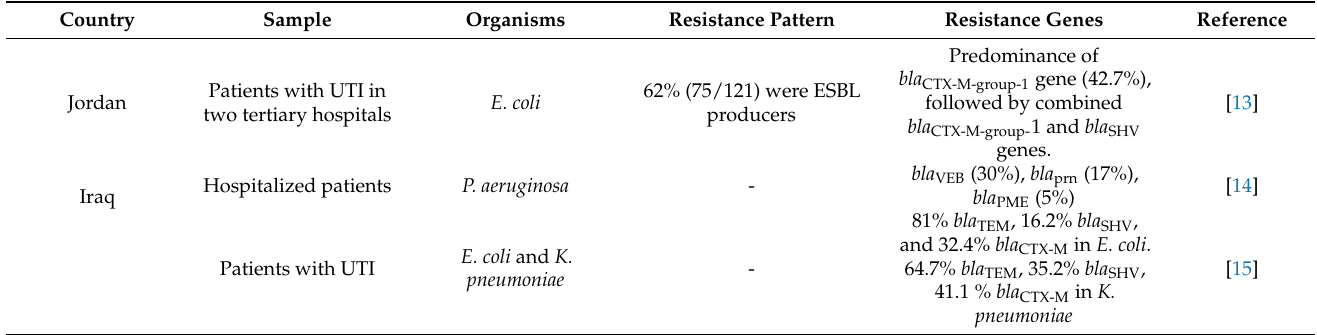
Table 1. Investigations of Extended Spectrum β -Lactamase infections in the Arabian